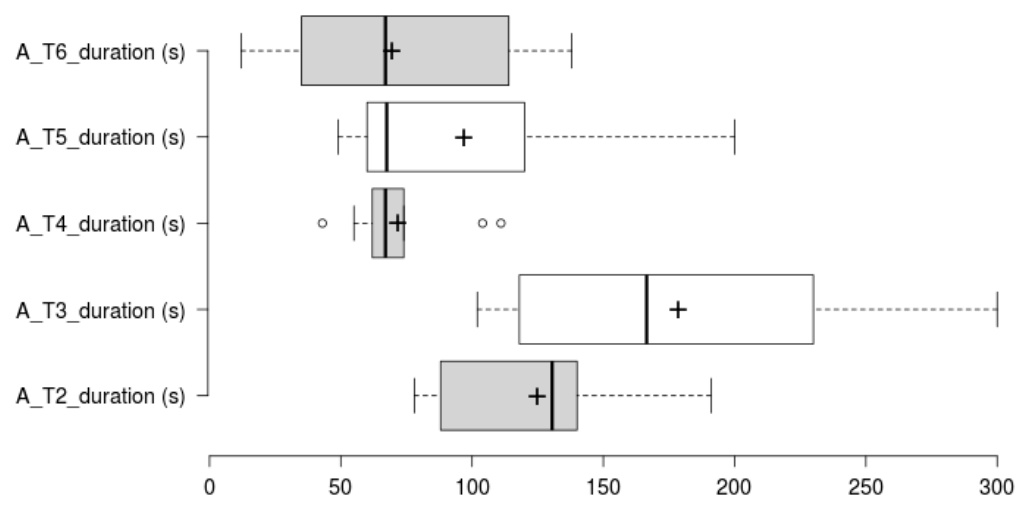
Figure 15. Tasks 2–6 duration variability. Box plot showing overall duration scores for task 2–6. The plus sign denotes the average value. It does not include expert user’s duration.